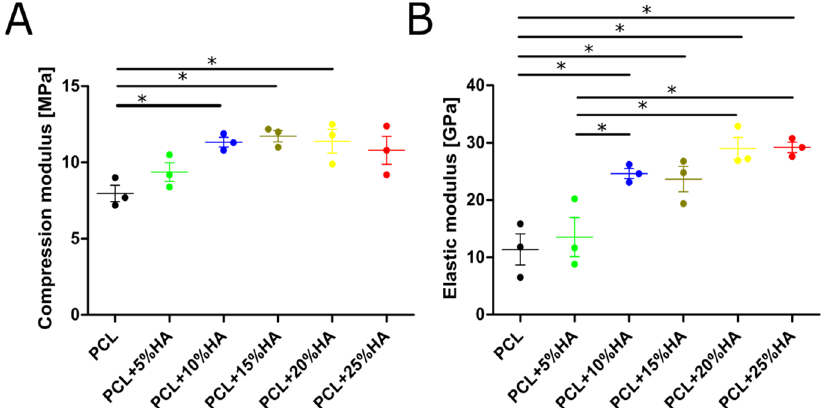
Figure 6. Mechanical test of the scaffolds. ( A ) Compressive strength after 20% deformation (MPa). ( B ) Elastic modulus obtained between 2% to 5% deformation (GPa). Graphs represent mean ± s.e.m, one-way ANOVA paired data + Tukey’s post hoc test, * = p < 0.05.